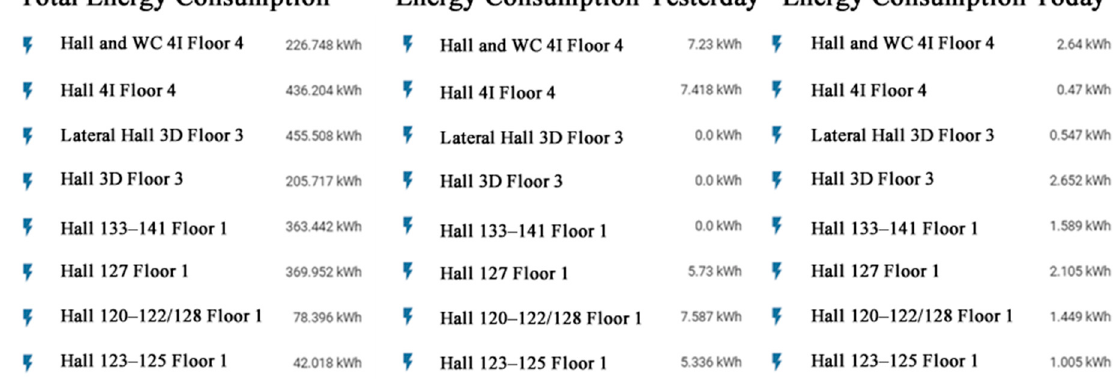
Figure 15. Electricity consumption for all electrical systems .